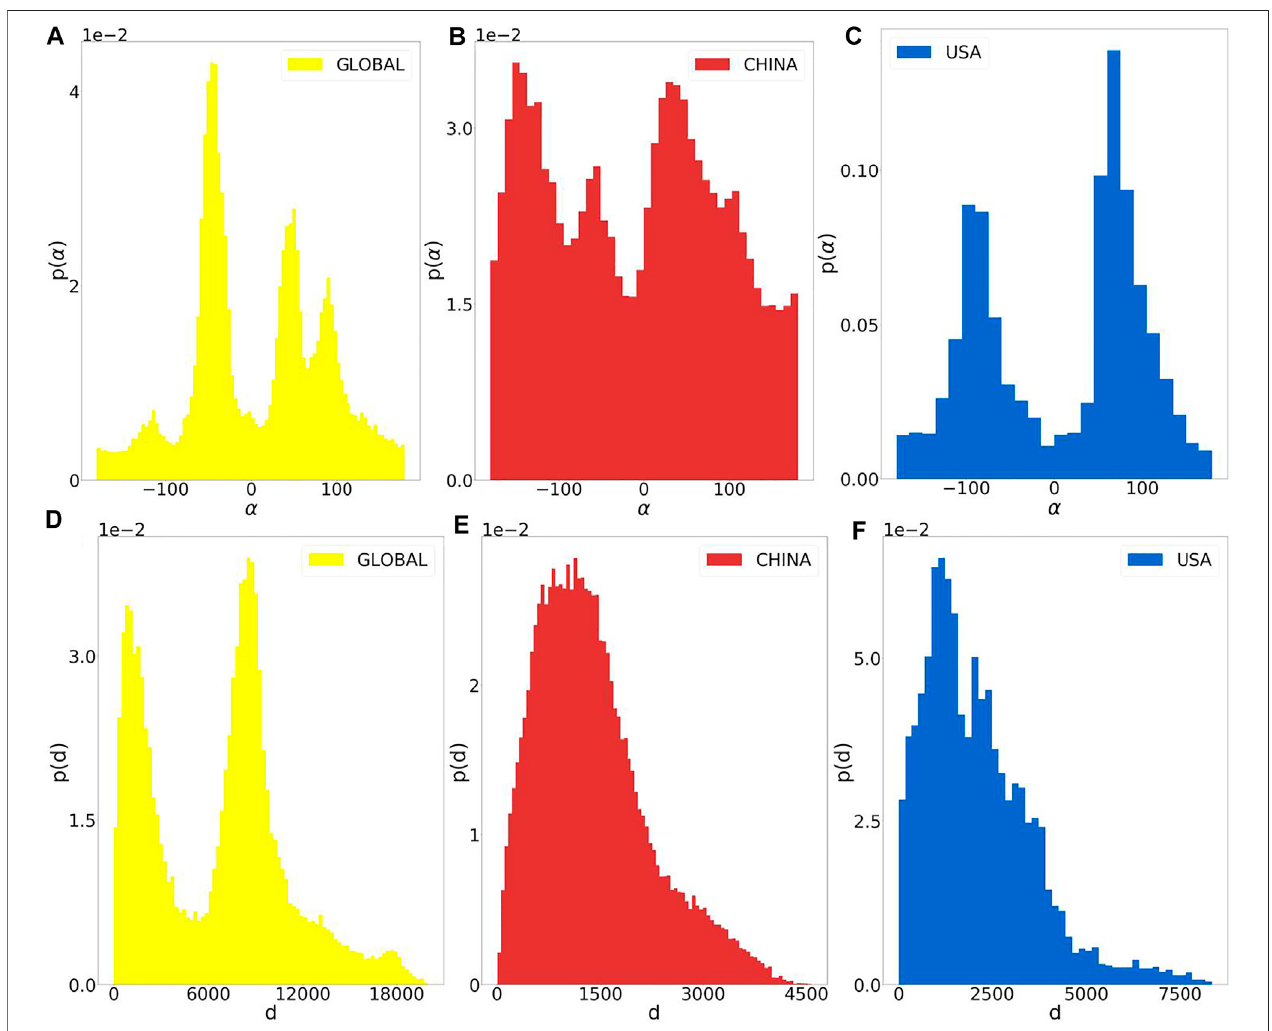
FIGURE 1 | The distribution of azimuth α and distance d. (A) shows the distribution of Azimuth a for the global dataset, (B) shows the distribution of the Chinese data set, and (C) shows the distribution of the American data set. (D) presents the distribution of distance d for the global station; (E) presents the distribution for the Chinese station, and (F) presents the distribution for the American